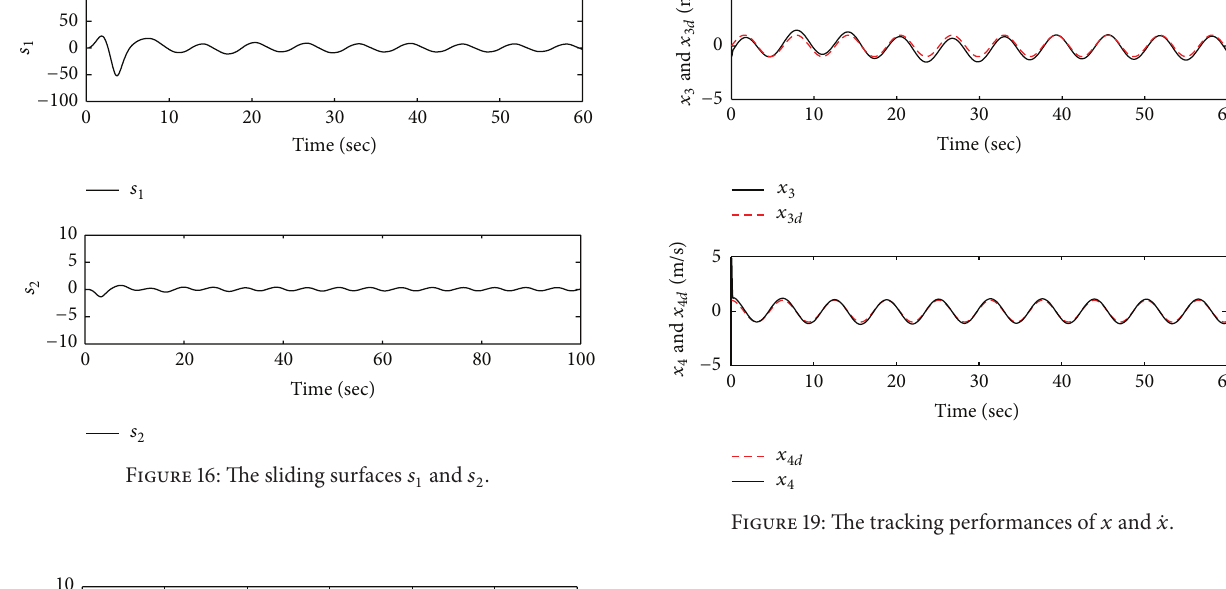
Figure 17: The control law 𝑢 .